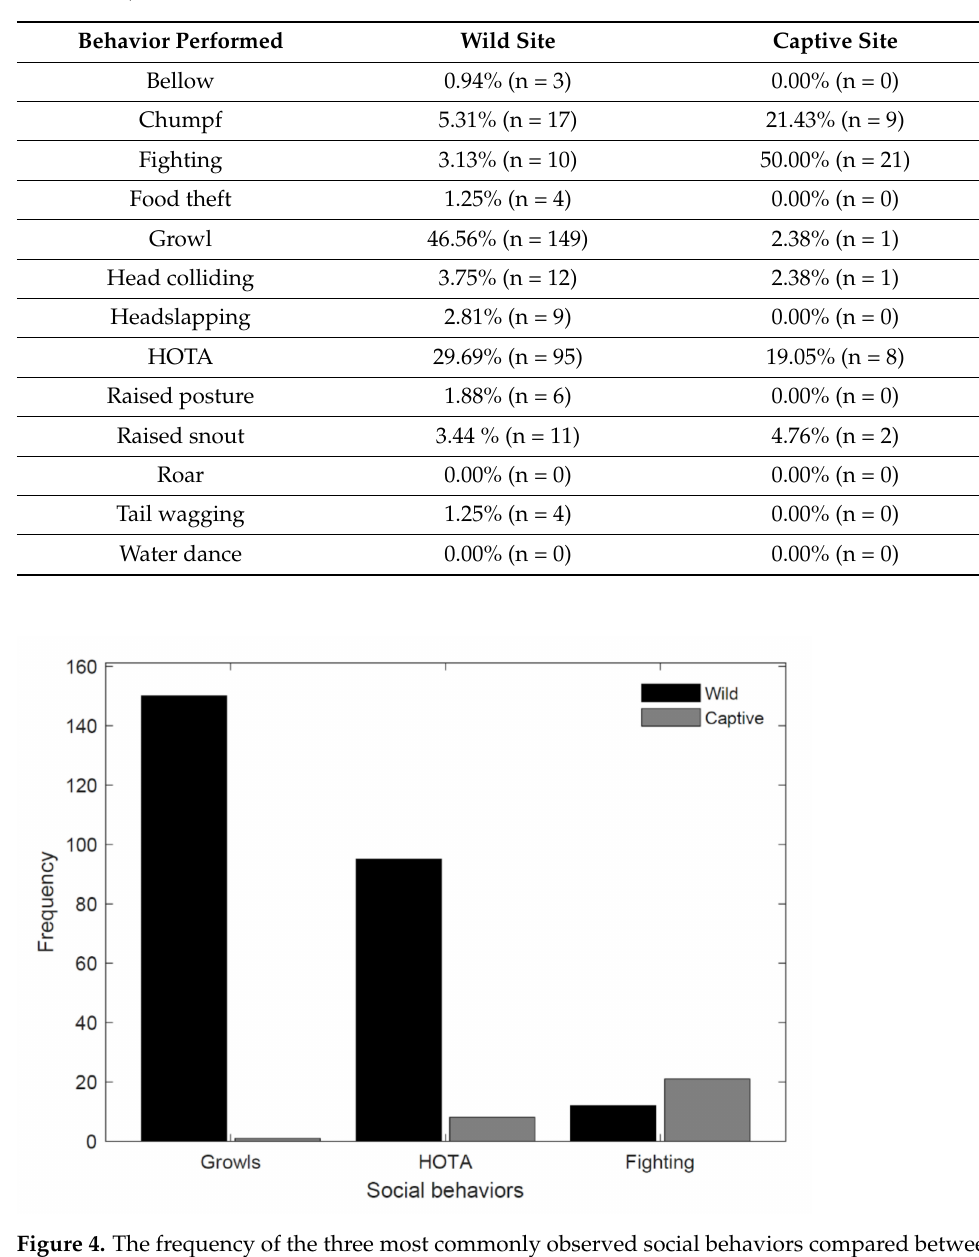
Figure 4. The frequency of the three most commonly observed social behaviors compared between the captive and wild